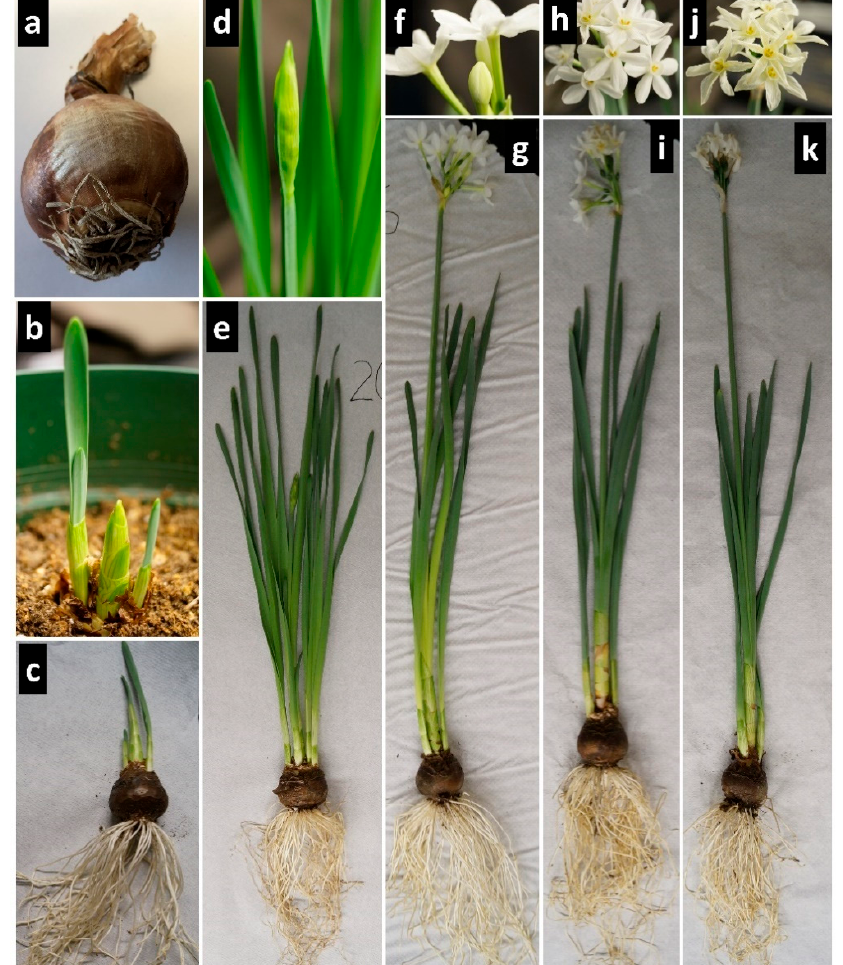
Figure 2. Photos showing the developmental stages of Narcissus papyraceus used in this study. ( a ) Stage 1: Unplanted bulb; ( b – c ) stage 2: Emergence with presence of young leaves; ( d – e ) stage 3: Presence of stems with unopened flower buds; ( f – g ) stage 4: Blossoming with emergence of young flowers; ( h – i ) stage 5: Flowering with mature flowers and ( j – k ) stage 6: Senescence with wilting